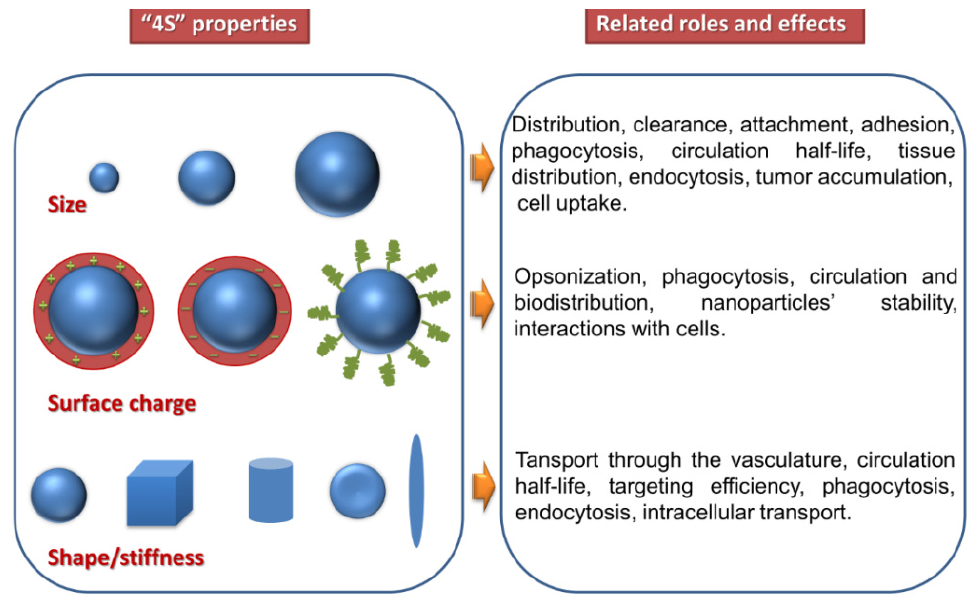
Figure 10. Physico-chemical properties (4S) influencing the fate of NPs after intravenous admin- istration.